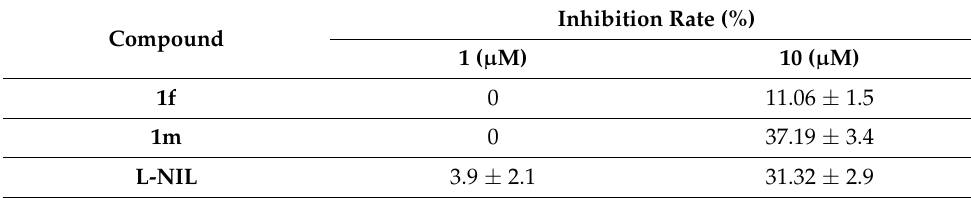
Table 2. Inhibitory effects of compounds 1f and 1m against NO production in LPS-induced RAW 264.7 cells.